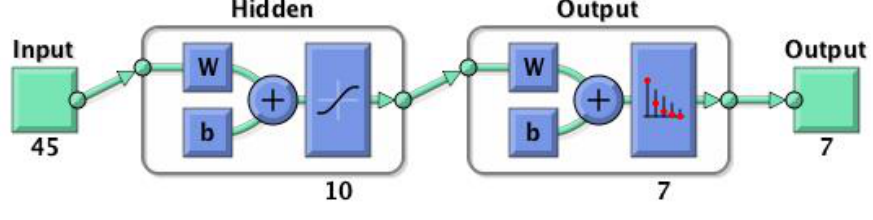
Figure 6. Neural network block